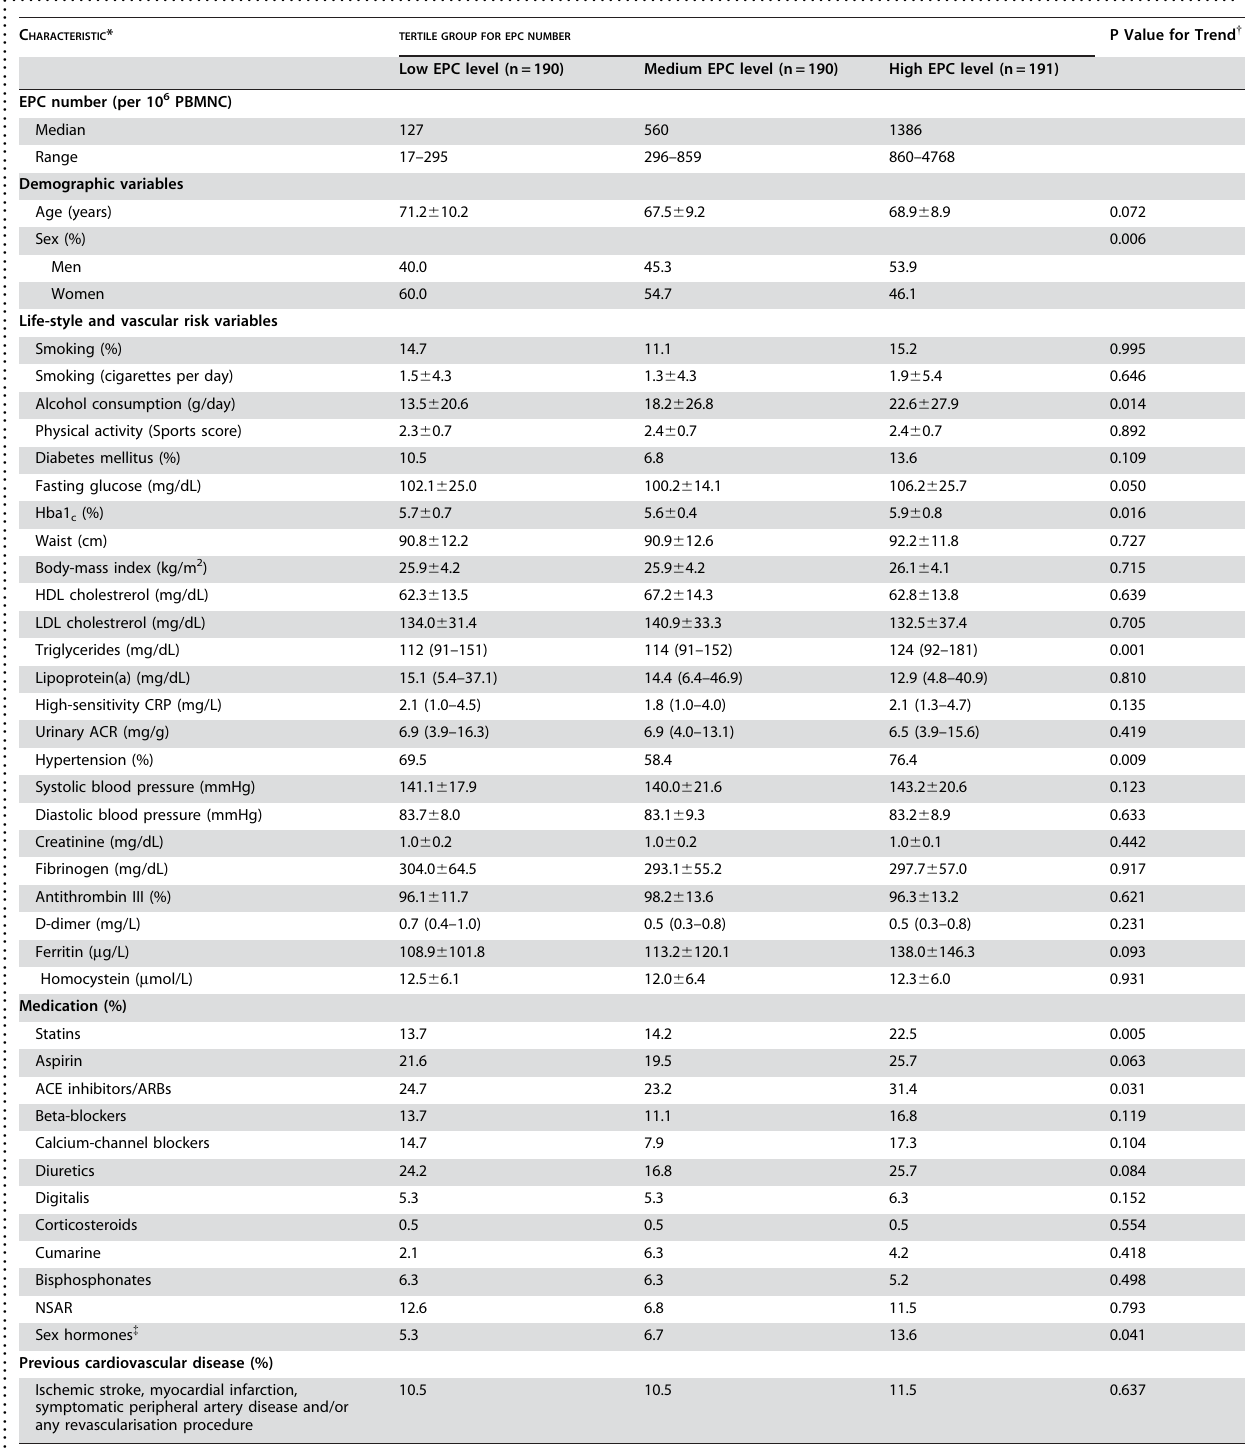
Table 1. Association of demographic and life-style characteristics, vascular risk factors, laboratory parameters and medication